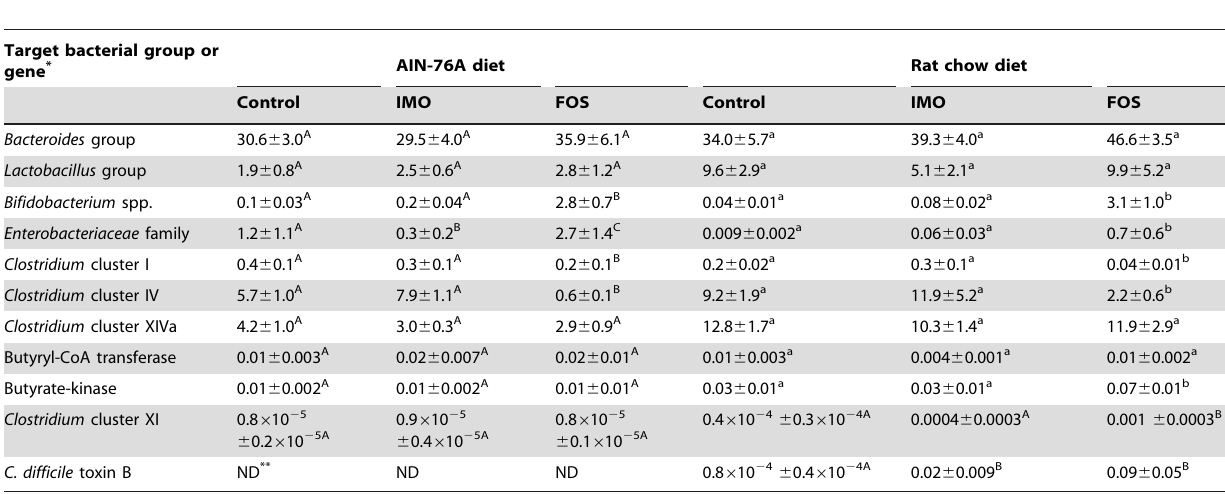
Table 2. Quantification of predominant bacterial groups and bacterial genes in cecal contents of HLA-B27 transgenic rats on AIN- 76A diet or rat chow diet at the end of the experimental treatment period (16 weeks of